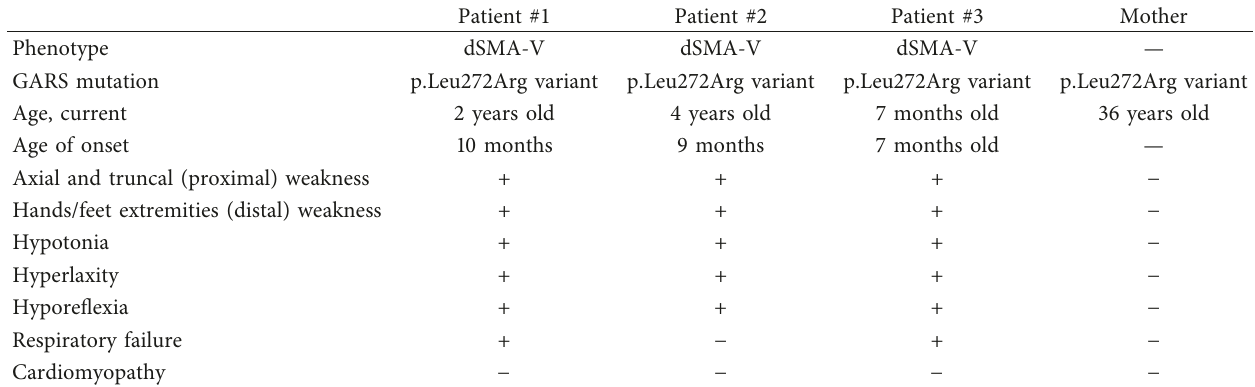
Table 1: Features and characteristics of patients’